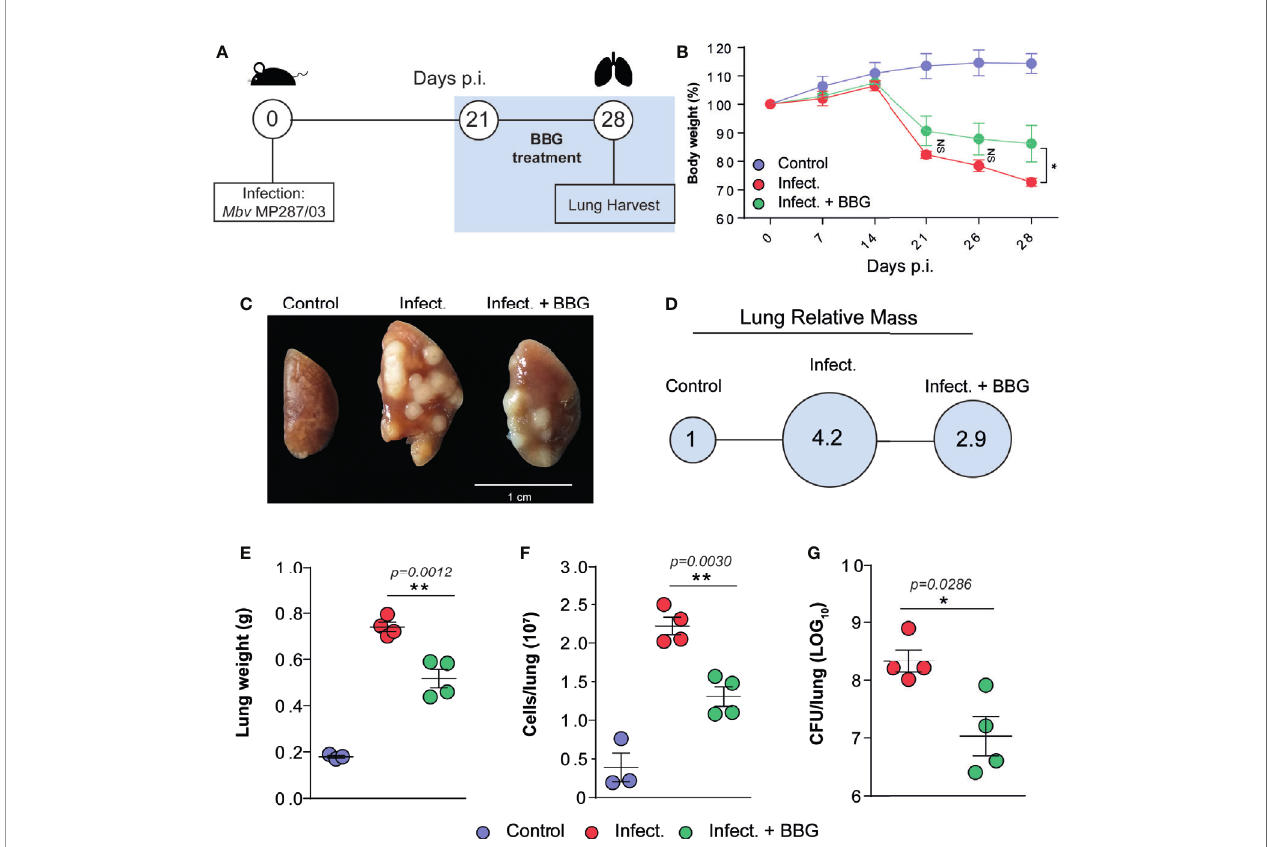
FIGURE 2 | P2X7 pharmacological blockade at advanced pulmonary TB reduces the disease severity in mice. C57BL/6 mice were infected i.t. with ~100 MP287/03 bacilli. Uninfected mice were used as control group. The P2X7 inhibitor BBG was administered i.p. at a dose of 45 mg/Kg, every 2 days, from day 21 of infection. Infected (untreated) group received the vehicle (PBS). Mouse lungs were evaluated at day 28 of infection. (A) Schematic representation of the experimental BBG treatment protocol is shown. (B) Mouse body weights were determined weekly. (C, D) Macroscopic images of representative lung lobes and relative lung masses (circles) are shown. (E – G) Lung weights, cell numbers per lung and CFUs per lung are shown. Signi fi cant differences were observed between the indicated groups with * p < 0.05 and ** p < 0.01, using One-way ANOVA and Tukey ’ s post hoc tests or Mann-Whitney non-parametric T test. The statistical differences between uninfected and infected groups are not shown. Data are representative of two independent experiments with three to four mice in each